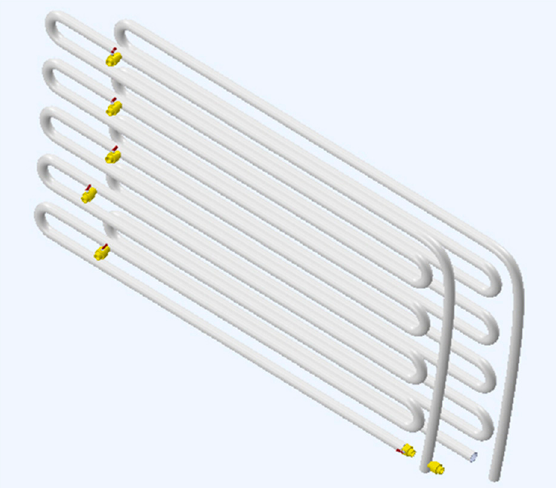
Figure 3. Partial view of zig-zag pipeline, first part of 70 m and back part of 50 m, serving as a hydraulic circuit for leak detection.